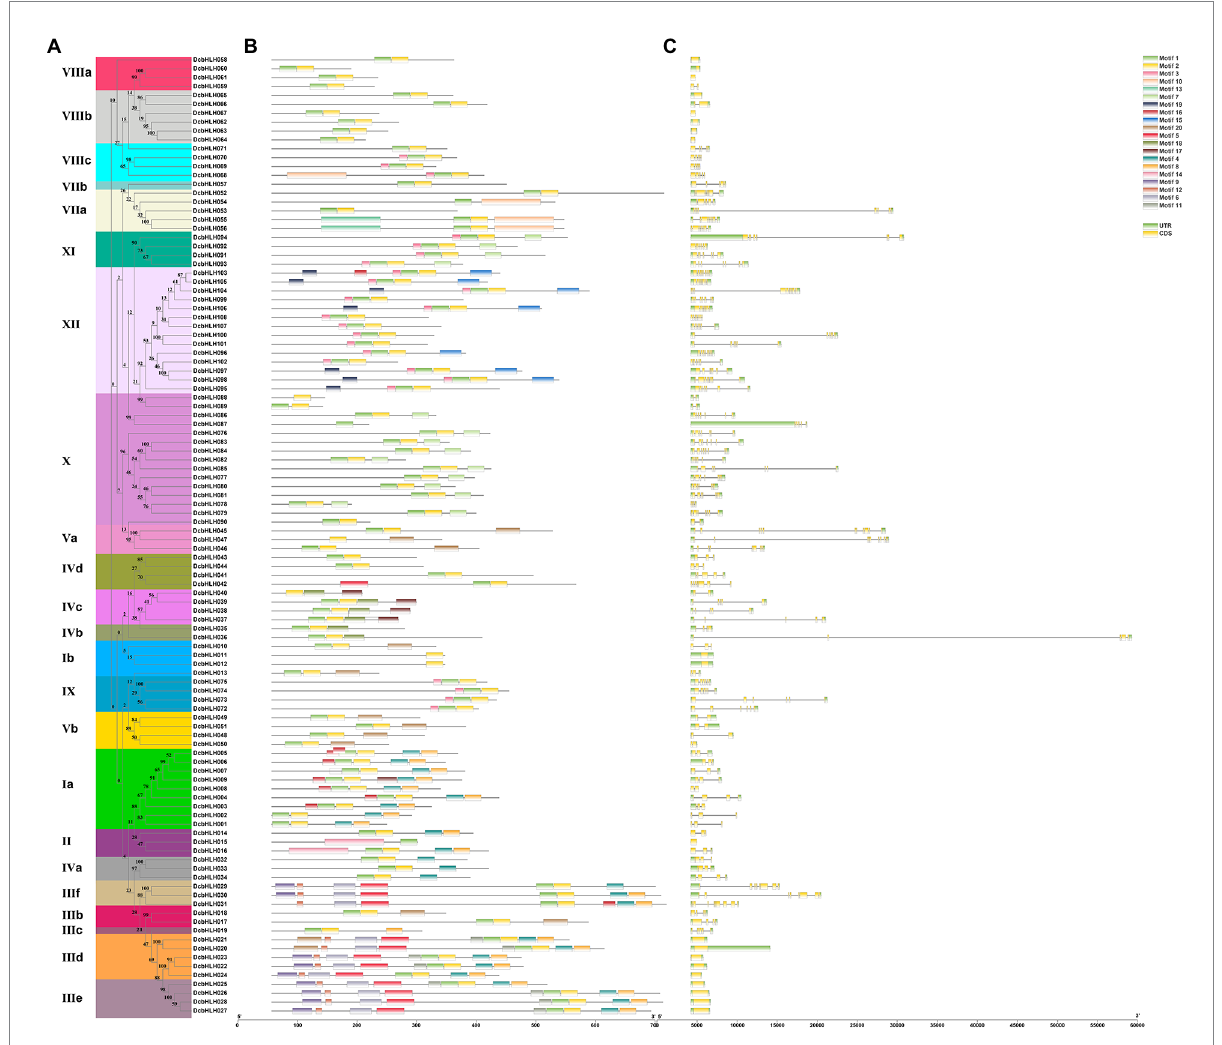
FIGURE 2 Phylogenetic relationships, architecture of conserved protein motifs, and gene structure in bHLHs of Dendrobium catenatum . (A) The phylogenetic tree of bHLH proteins. It was constructed according to the NJ method by MEGA 7.0 with 1,000 bootstrap replicates. Different color boxes represent different clades. (B) The conserved motif composition of bHLH proteins. Solid boxes of different colors represent different motifs, and the legend is on the right side of the figure. (C) UTR-coding domain sequence (CDS) structure of bHLH genes. The green box represents UTRs, and the yellow box represents